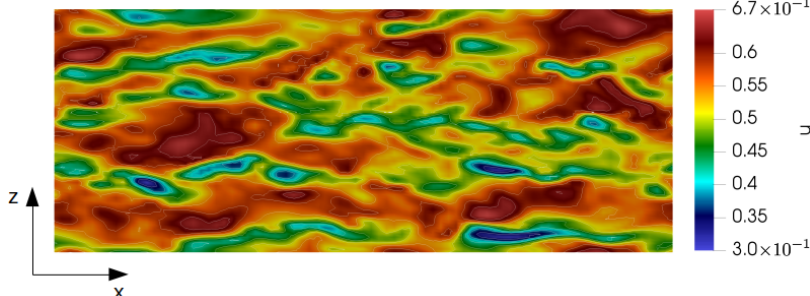
Figure 16. Instantaneous streamwise velocity contour at a xz plane—Particle Free (PF).